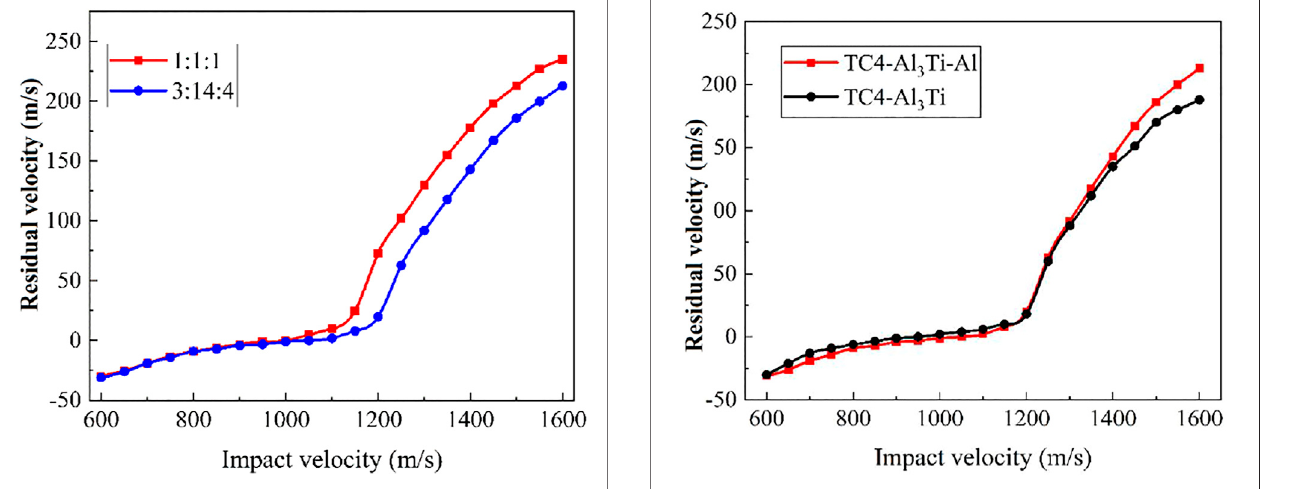
FIGURE 3 | Curve of impact and residual velocities of TC4-Al 3 Ti-Al targets with different layer thickness ratios.